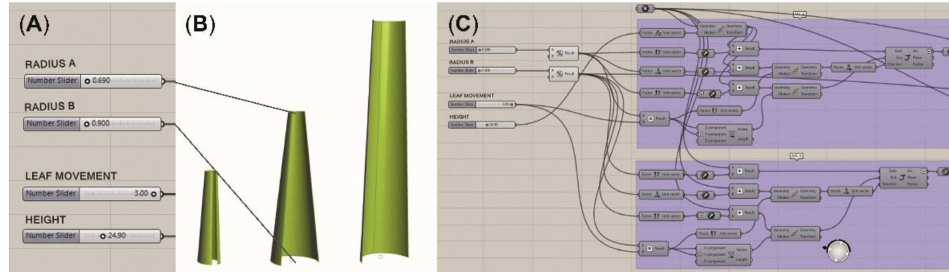
Figure 9. Parametric leaf-blade: ( A ) Parameters; ( B ) Different degrees of leaf blade radius, height, and opening; ( C ) algorithm. Source: Authors.